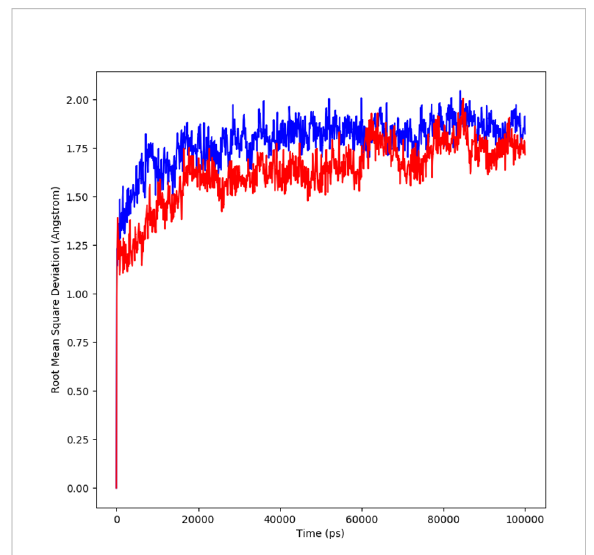
FIGURE 4 RMSD pro fi le of protein-ligand complex (red) and protein complex (blue) for 100 ns of MD simulation.